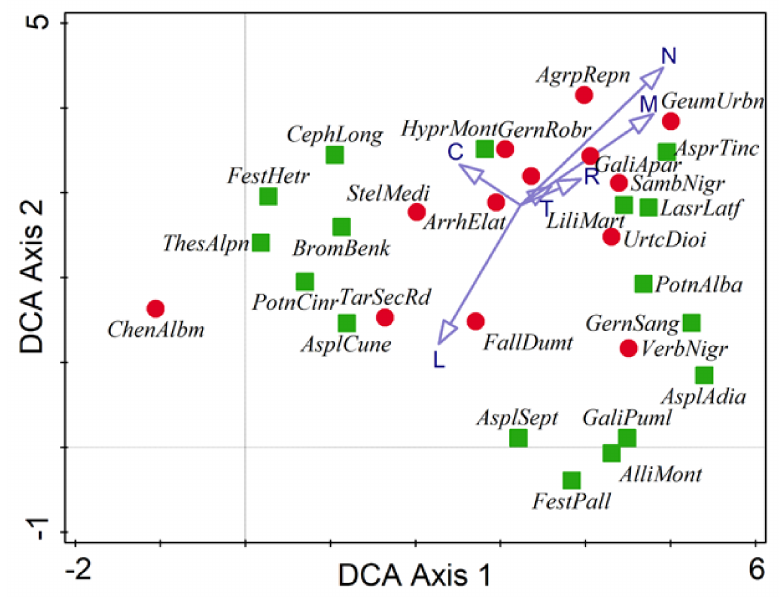
Figure 4. The passive projection of Ellenberg indicator values (EIVs) into DCA distribution diagram of nitrophilic (red circles) and rare/endangered species (green squares) recorded in serpentine forest communities in SW Poland. Species scores limit to 30 by weight. Abbreviations of species names are in accordance with these presented in Tables 2 and 3. Explanation: C—EIV for continentality; T—EIV for temperature; L—EIV for light; M—EIV for moisture; R—EIV for soil reaction; N—EIV for nutrients.